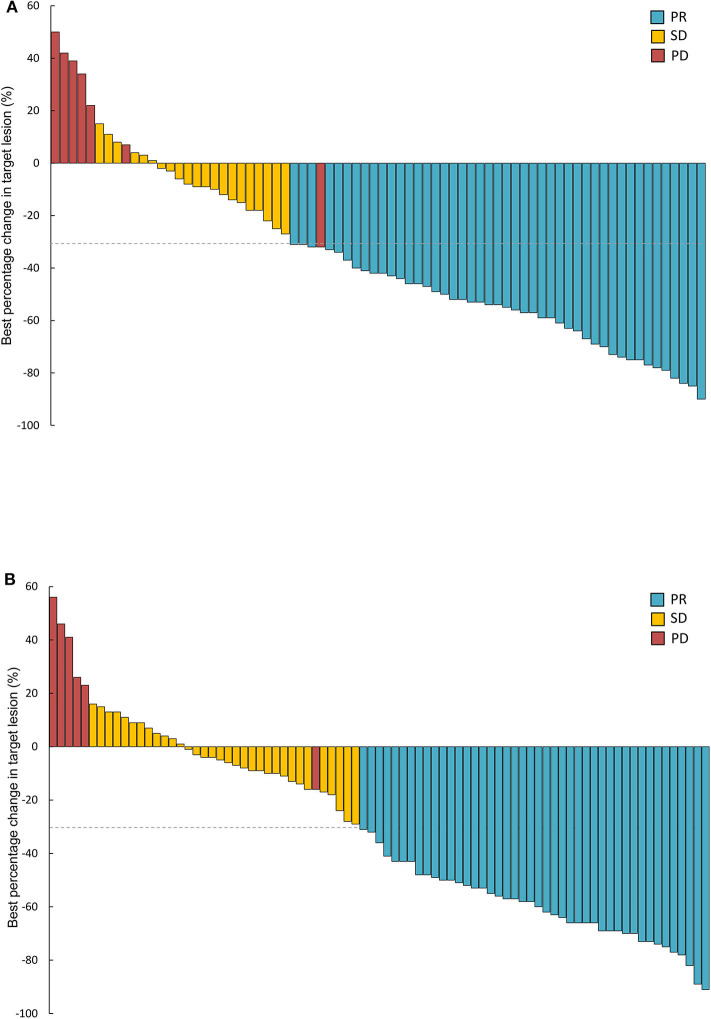
Waterfall plots of best percentage changes in the target lesions at baseline in two groups. (A) Erlotinib 100 mg/d group (n = 74). (B) Gefitinib 250 mg/d group (n = 83). PR, partial response; SD, stable disease; PD, progressive disease.